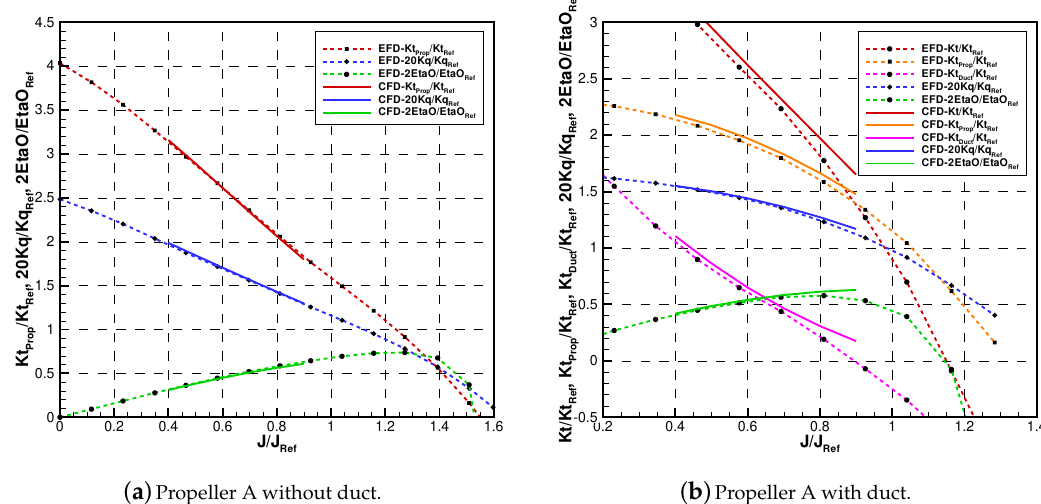
Figure 3. Open water tests for the accelerating ducted propeller: computational fluid dynamics (CFD; solid lines) vs. experimental fluid dynamics (EFD; dashed